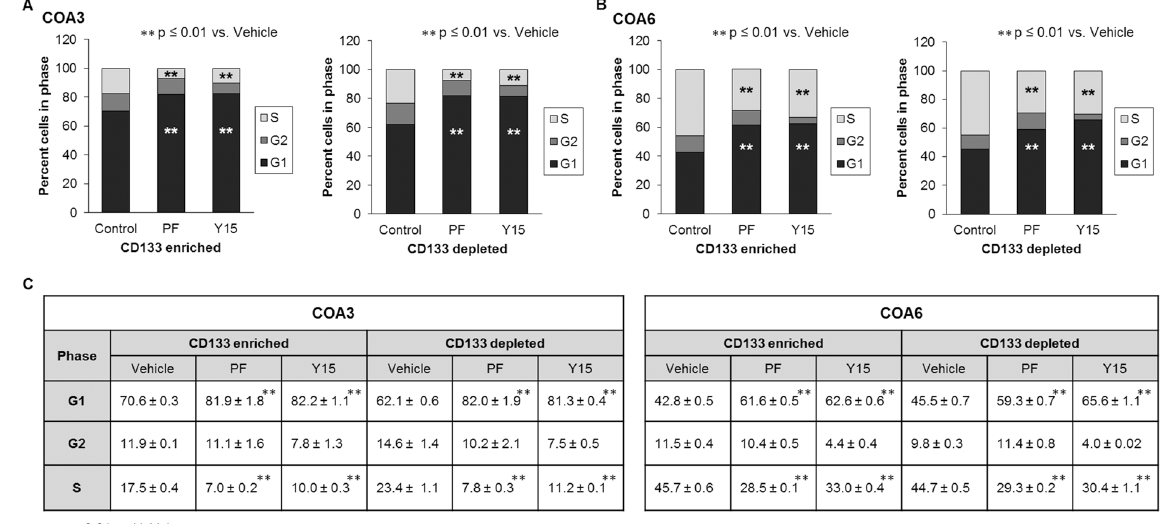
Figure 8. FAK inhibition diminished progression of both CD133-enriched and depleted cell populations through the cell cycle. COA3 and COA6 cells were sorted using a magnetic cell sorting system into CD133- enriched and CD133-depleted population. Cells (3 × 10 6 ) were treated with PF (0, 5 μ M) or Y15 (0, 5 μ M) for 72 hours, stained with propidium iodide and cell cycle was analyzed via flow cytometry. ( A ) FAK inhibition led to an increase in percent of COA3 cells in the G1 phase and a decrease of those in S phase in both the CD133-enriched and depleted populations, representing failure to progress through the cell cycle. ( B ) FAK inhibition led to an increase in percent of COA6 cells in the G1 phase and a decrease of those in S phase in both the CD133-enriched and depleted populations, representing failure to progress through the cell cycle. ( C ) Cell cycle data are presented in tabular form. Data represent at least three biologic replicates and are reported as mean ± SEM.